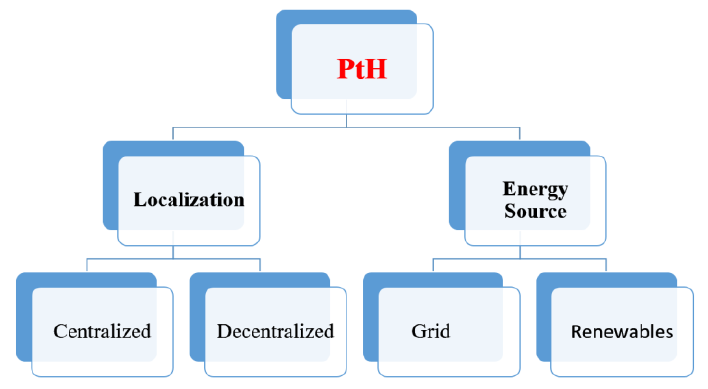
Figure 1. Schematic concept of power-to-heat technologies.